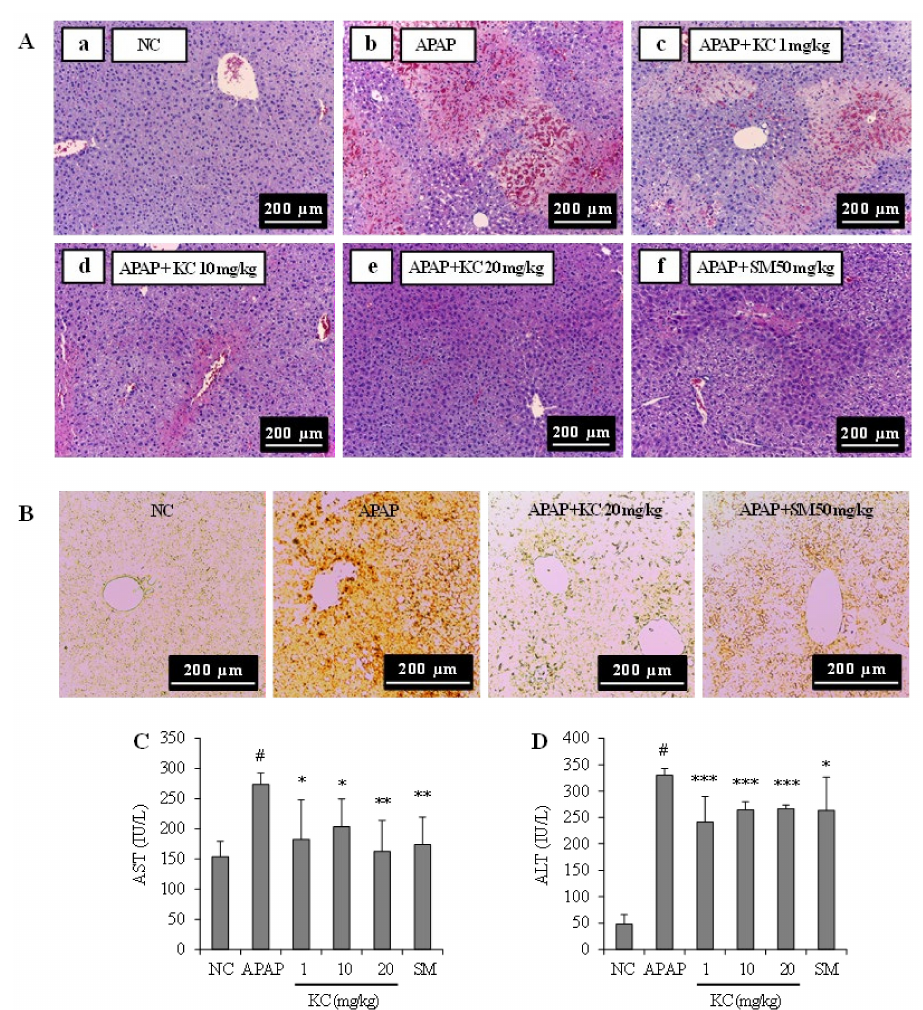
Figure 6. Effect of kushenol C on APAP-induced hepatotoxicity in mice. Thirty mice were partitioned into six groups (n = 5): group 1, normal control; group 2, APAP 500 mg/kg; group 3, APAP plus KC 1 mg/kg; group 4, APAP plus KC 10 mg/kg; group 5, APAP plus KC 20 mg/kg; group 6 (a positive control), APAP plus silymarin (SM) 50 mg/kg. ( A ) Hematoxylin and eosin-stained sections of the mice liver showing hepatotoxicity and inflammation. ( B ) Immunohistochemically stained sections of the liver showing the expression of cleaved caspase 3. ( C , D ) AST and ALT levels were measured in the serum of each mouse. Error bars represent the mean ± SD, # p < 0.001 vs. NC group, * p < 0.05, ** p < 0.01, *** p < 0.001 vs. APAP-only treated